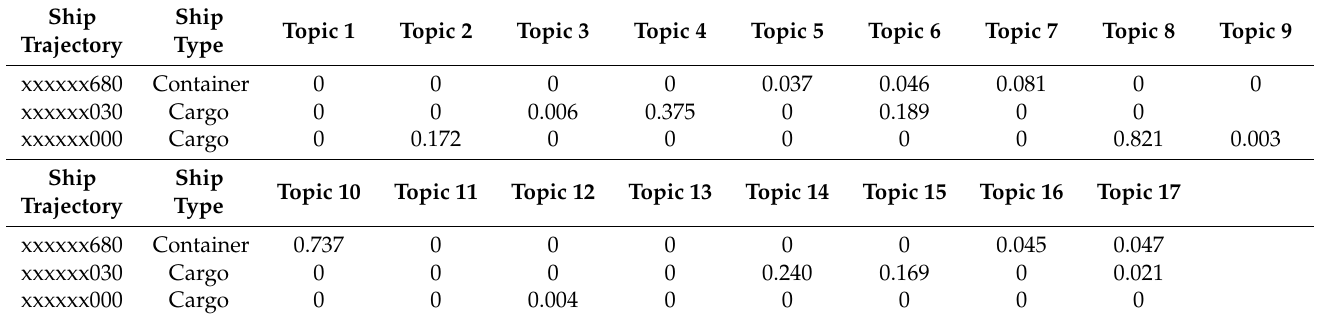
Figure 9. The change of topic correlation with topic number. Table 6. Trajectory probability distribution in